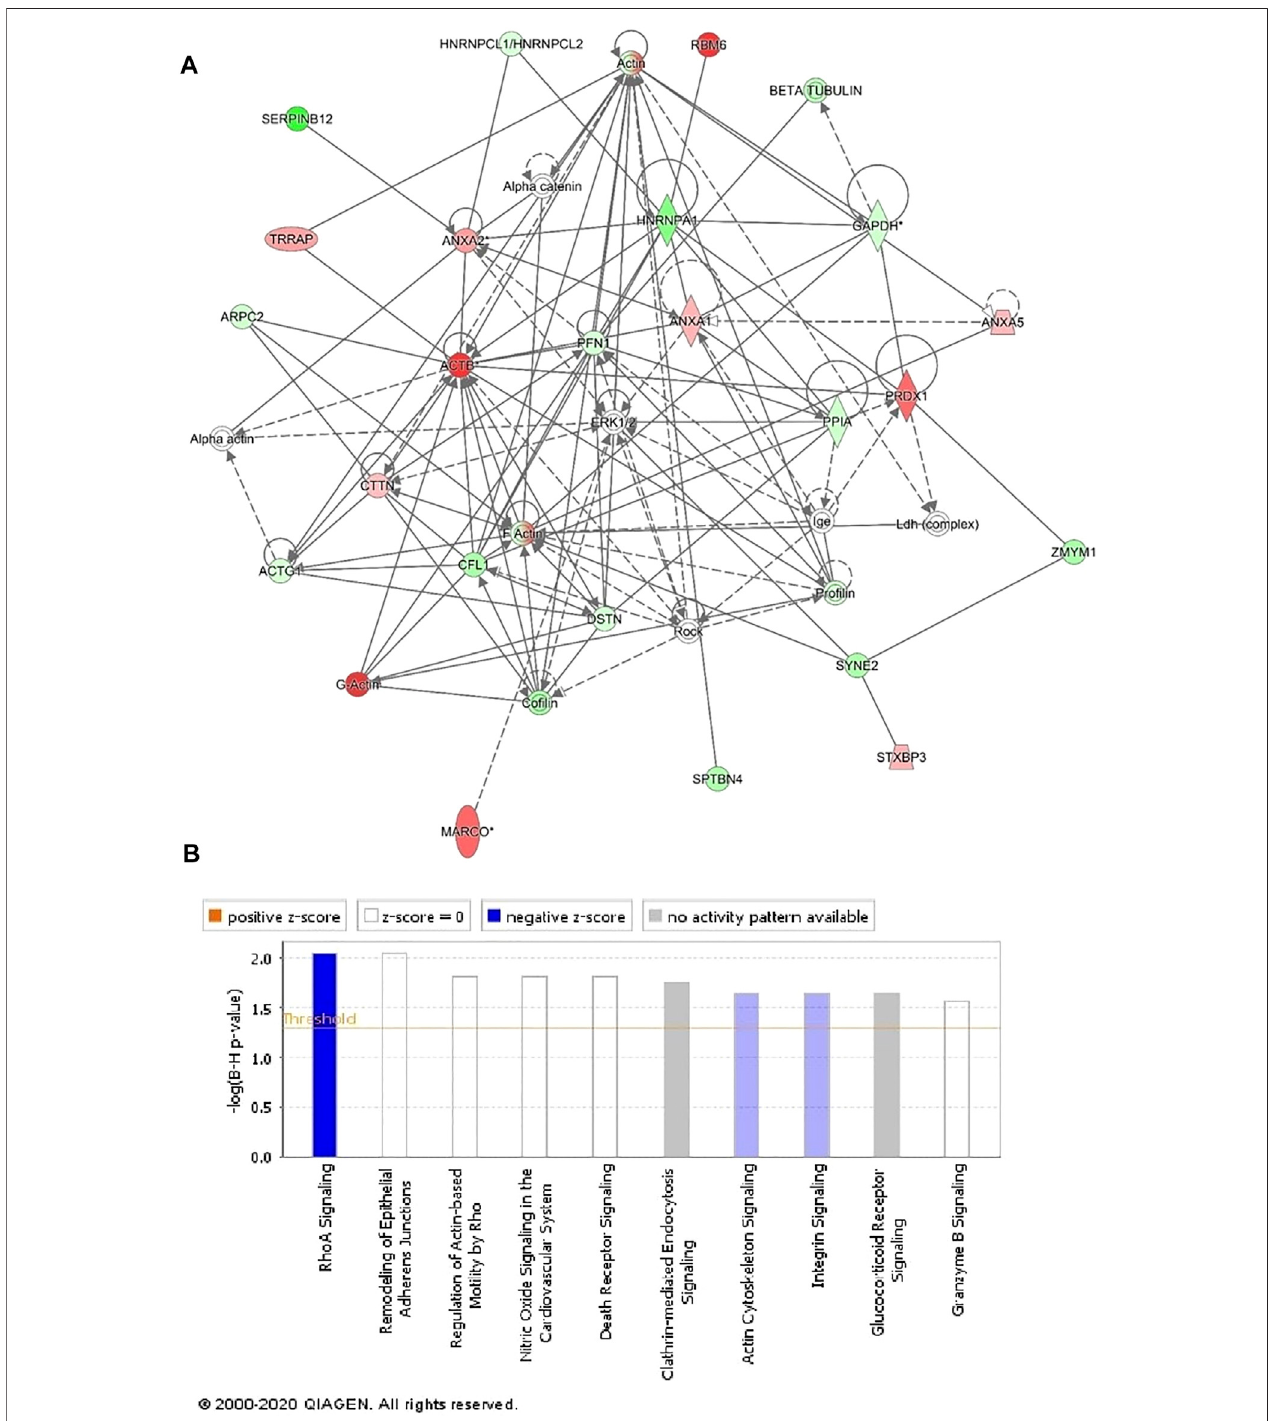
FIGURE4| Schematicrepresentationofthemostsigni fi cantIPAnetworksinvolvingthedifferentiallyregulatedproteinsbetweentheGAMOSandcontrolsamples. IPA analysis found that the functional interaction network pathway with the highest score was related to “ cellular assembly and organization, cellular function and maintenance,andtissuedevelopment. ” Thispathwayincorporated PFN1 , ERK1/2 ,and ACTB ascentralnodesdownregulatedinpatientswithGAMOS.Nodesingreen andredcorrespondtodownregulatedandupregulatedproteins,respectively. (A) ColorlessnodeswereproposedbyIPAandsuggestpotentialtargetsfunctionally coordinated with the differentially abundant proteins. Solid lines indicate direct molecular interactions, and dashed lines represent indirect interactions. (B) Diagram shows the top canonical pathways ranked by the p -values obtained by the IPA.